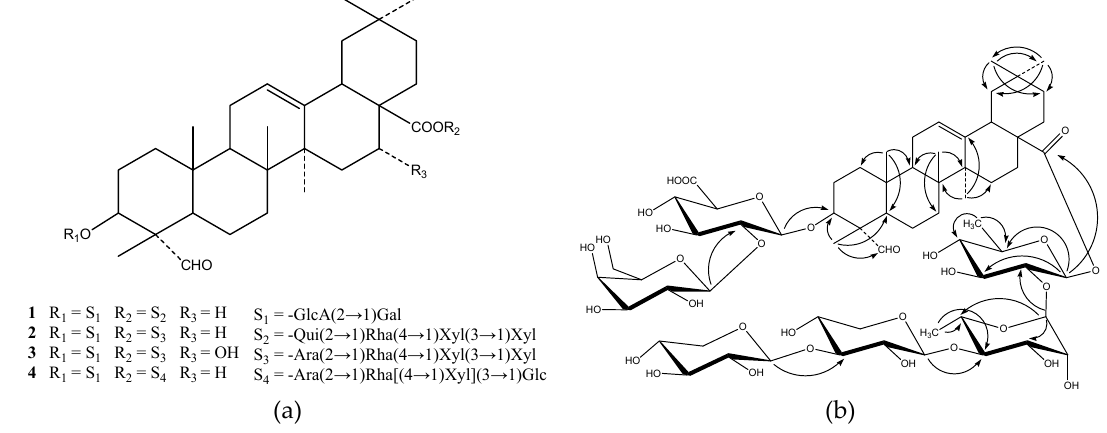
Figure 1. ( a ) Chemical structures of compounds 1 – 4 ; ( b ) Key HMBC correlations of compound 1 (arrows point from proton to carbon).